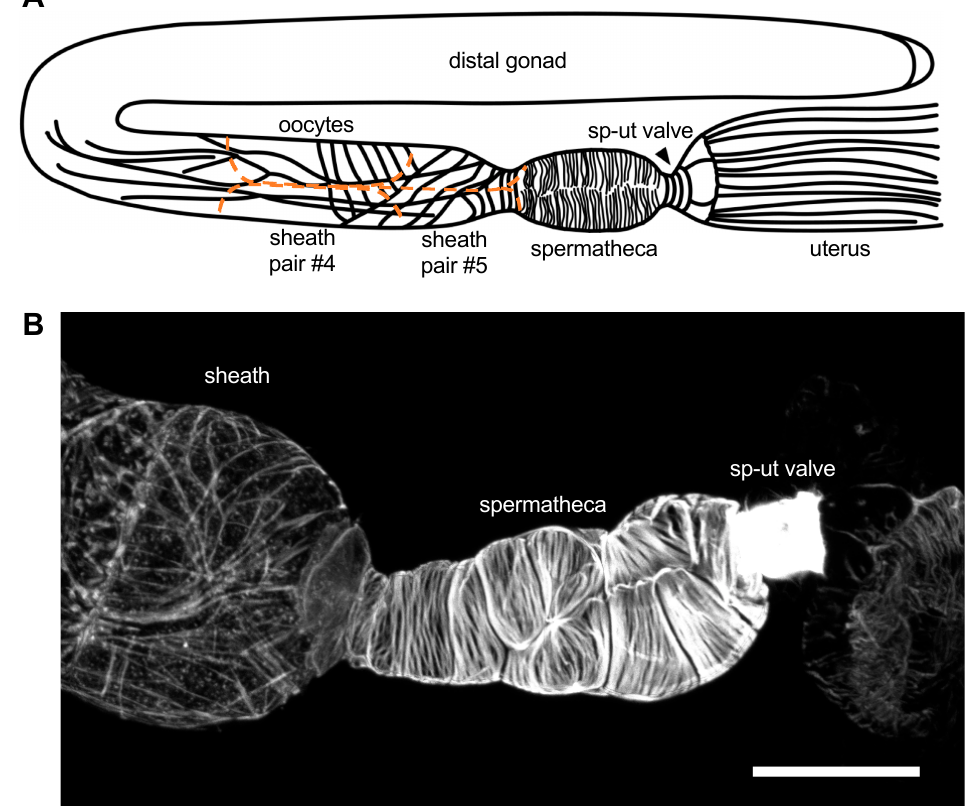
Figure 1. Actin networks in the C. elegans somatic gonad. ( A ). Diagrammatic representation of the C. elegans gonadal anatomy. Sheath cells are outlined in orange and oocytes are in grey. ( B ). Phalloidin stain of a dissected C. elegans gonad, demonstrating the actin structures observed in the sheath, spermatheca, and spermathecal–uterine (sp–ut) valve. Scale bar 20 micrometers.